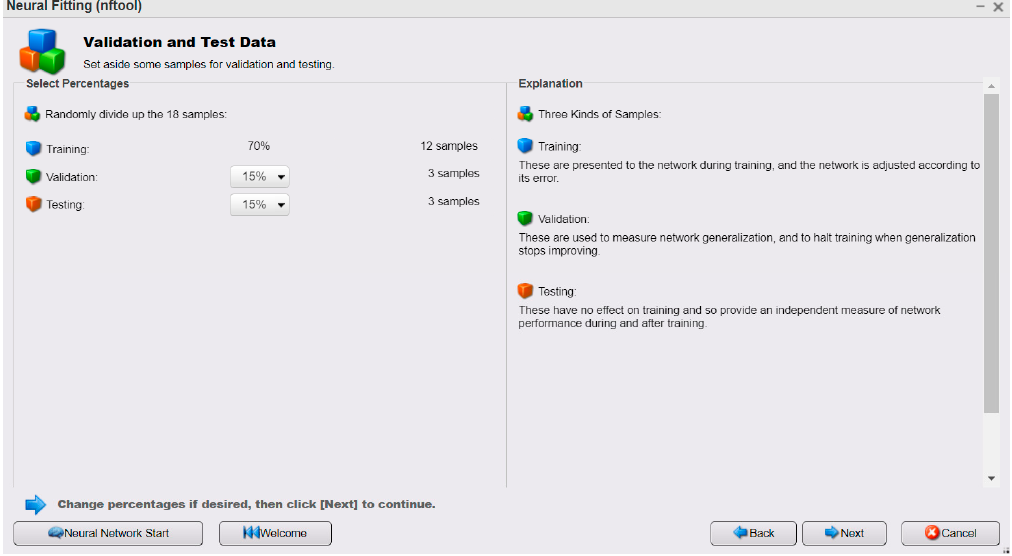
Figure 25 . Neural fitting tool showing sample size.